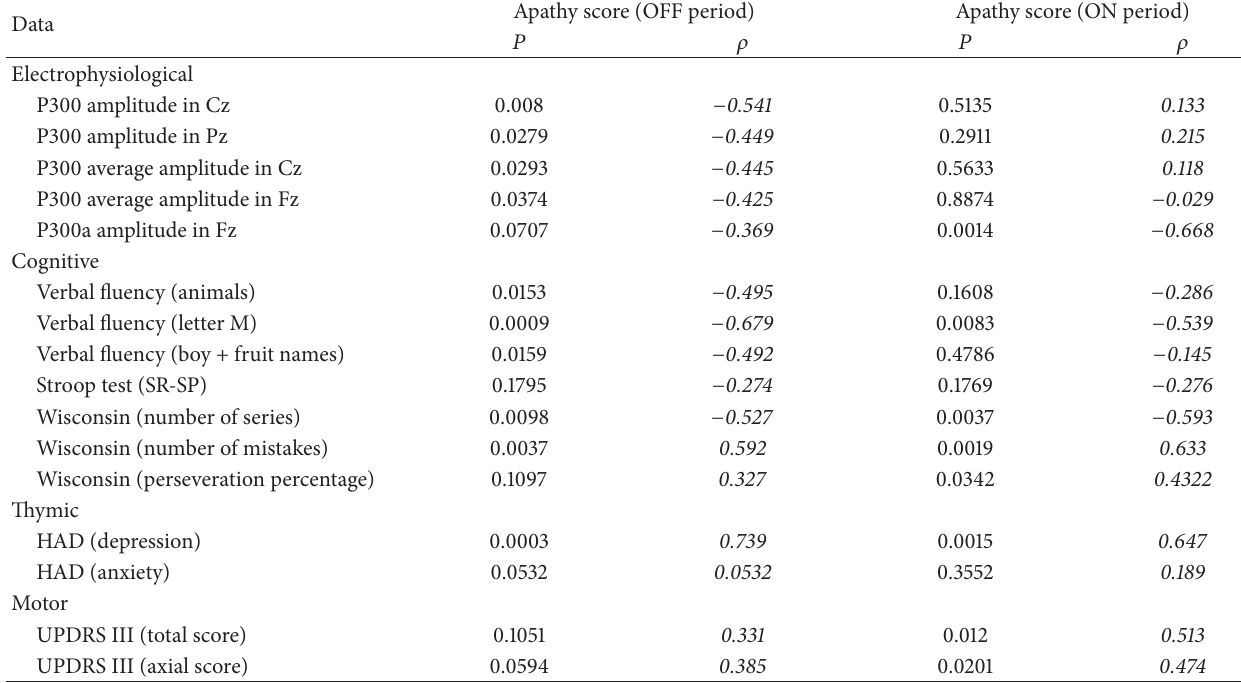
Table 1: Correlation between the apathy score (during OFF and ON periods) and electrophysiological cognitive, thymic, and motor data.